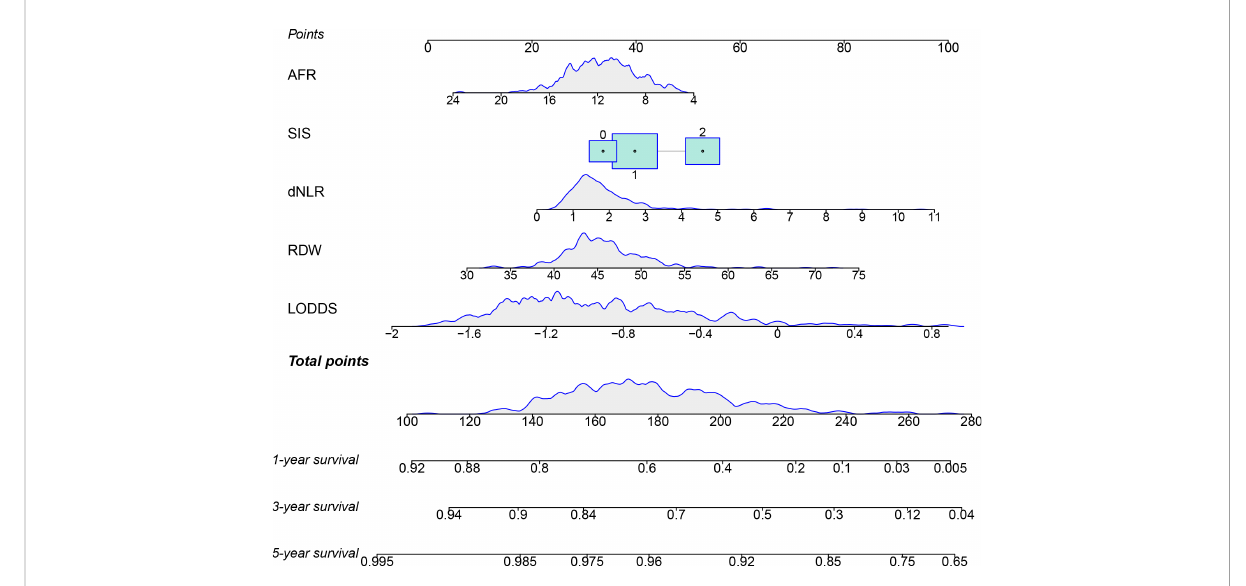
FIGURE 4 The nomogram for predicting the 1-, 3-, and 5-year survival of ESCC patients after radical